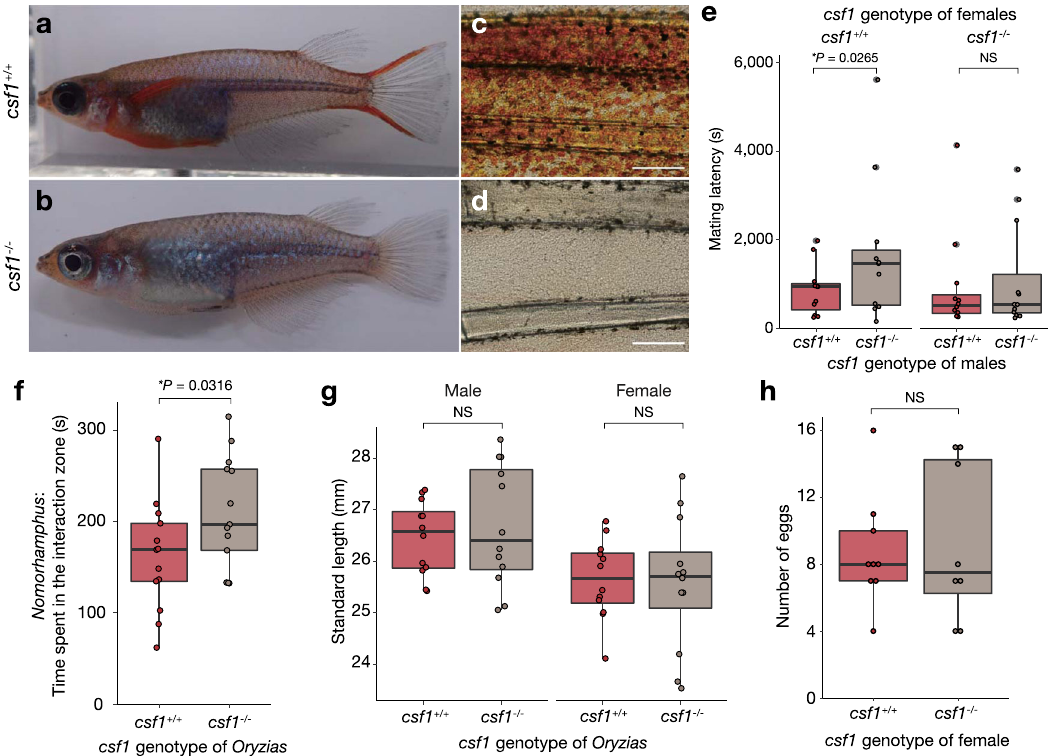
Fig. 4 Role of csf1 in red coloration and fi tness components. a , b Representative images of wild-type ( csf1 + / + ) ( a ) and knockout ( csf1 − / − ) O. woworae males ( b ). c , d Microscopic images of the pectoral fi ns of csf1 + / + ( c ) and csf1 − / − fi sh ( d ). Scale bars indicate 200 µ m. Images are representative of three experiments. e Comparison of mating latency between O. woworae with csf1 + / + and csf1 − / − . The mating behaviors were observed in 46 pairs: 11 pairs of csf1 + / + female and csf1 + / + male; 11 pairs of csf1 + / + female and csf1 − / − male; 12 pairs of csf1 − / − female and csf1 + / + male; 12 pairs of csf1 − / − female and csf1 − / − male. * P < 0.05 and not signi fi cant (NS) according to two-sided post hoc analysis with Tukey ’ s multiplicity adjustment method in a generalized linear mixed model (GLMM). f Comparison of the behavioral preferences of male halfbeaks ( Nomorhamphus cf. ebrardtii ) for csf1 + / + and csf1 − / − O. woworae males ( n = 13 halfbeaks). The X axis indicates the csf1 genotype of O. woworae males and the Y axis indicates total time spent in each interaction zone by the halfbeaks during a 20-min behavioral test. The P -value (* P < 0.05) was calculated using the Wald test in a linear mixed model. e , f Each dot represents a single behavioral experiment. g No signi fi cant difference was found in the standard length between the csf1 + / + and csf1 − / − O. woworae adults that were used for the mating behavioral assay ( n = 12 for each). Each dot indicates each individual. NS, not signi fi cant by two-way ANOVA. h No signi fi cant difference in the clutch size was found between the csf1 + / + and csf1 − / − O. woworae females ( n = 9 for csf1 + / + and n = 8 for csf1 − / − ). g , h Each dot represents a single individual. NS, not signi fi cant according to the two-sided Mann – Whitney U test. e – h The red and gray colors indicate csf1 wild-type and knockout fi sh, respectively. In the box-plots, the center line indicates the median, box limits indicate the upper and lower quartiles, the whiskers indicate 1.5× interquartile range, and the points are outliers. Source data are provided as a Source Data fi